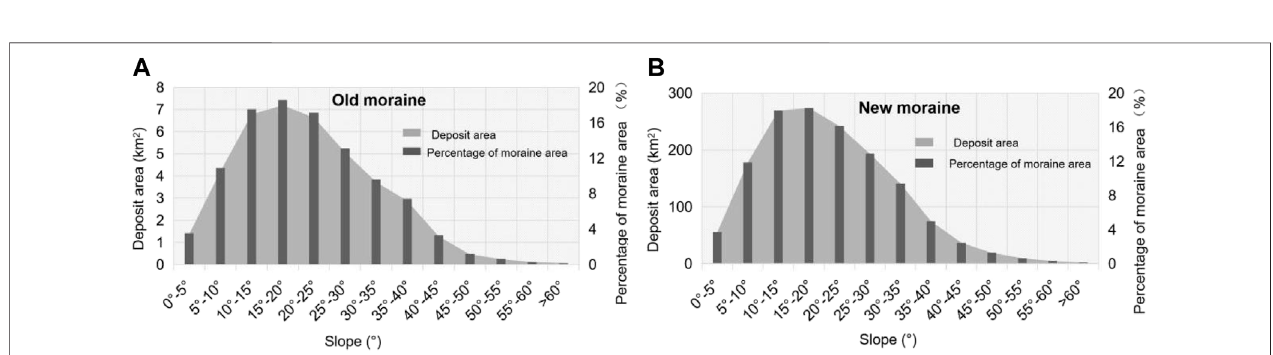
FIGURE 11 | Distribution characteristics of moraine on slope [ (A) Old moraine; (B) new moraine].